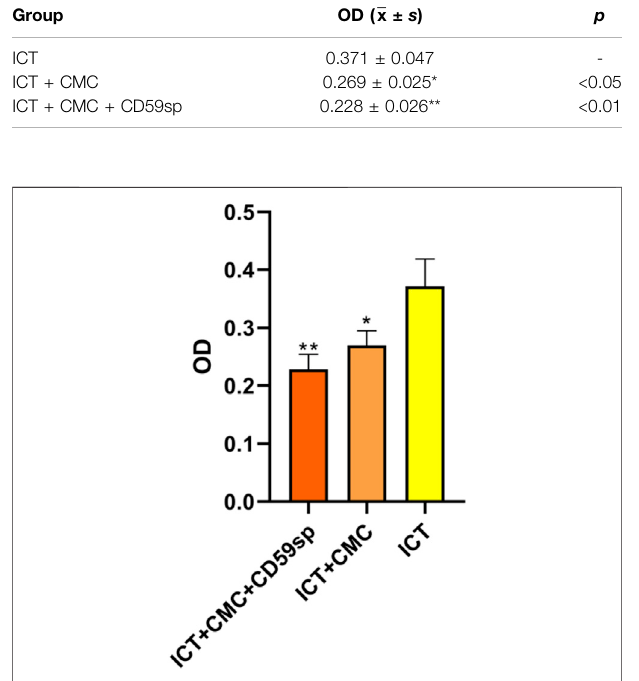
FIGURE 2 | Comparison of the synergistic antitumor effects of ICT/ CMC/CD59sp (* p < 0.05, ** p < 0.01).